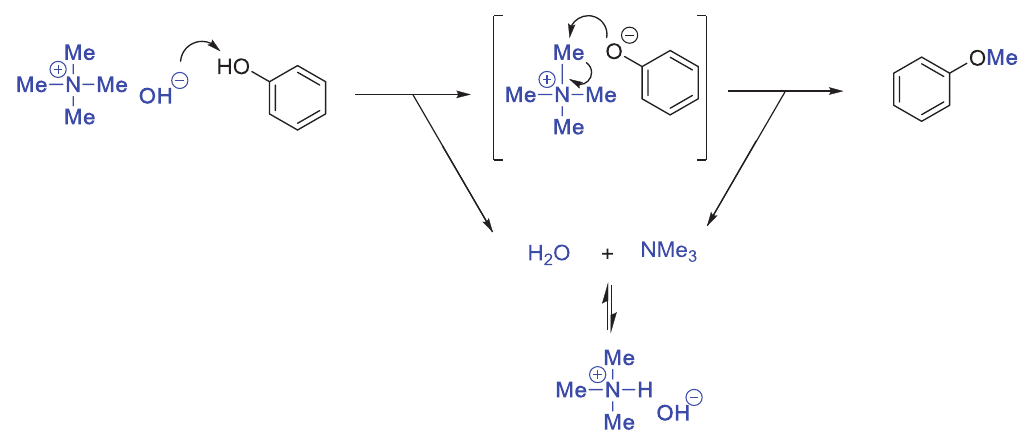
Figure 3: The reaction mechanism of methylation of phenolic component in the presence of TMAH.